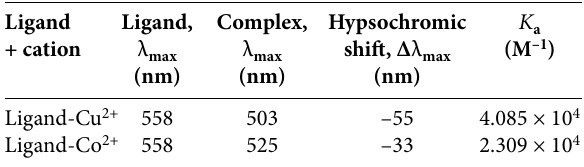
Table 2: UV-vis spectra data upon titration of compound 1 with cations in DMSO Ligand